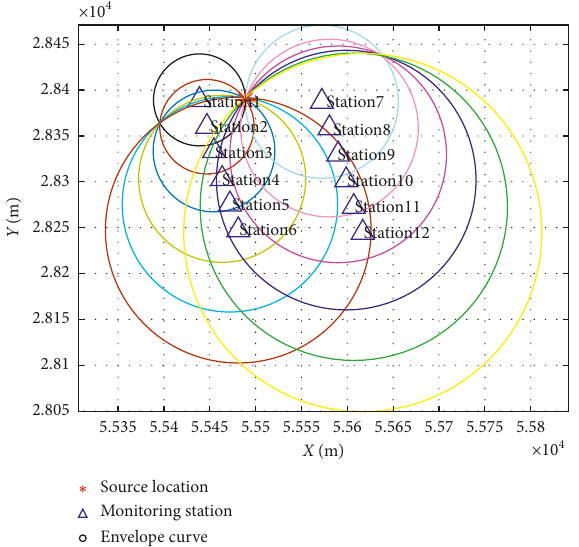
Figure 3: Sketch map of sensors (circles) and source